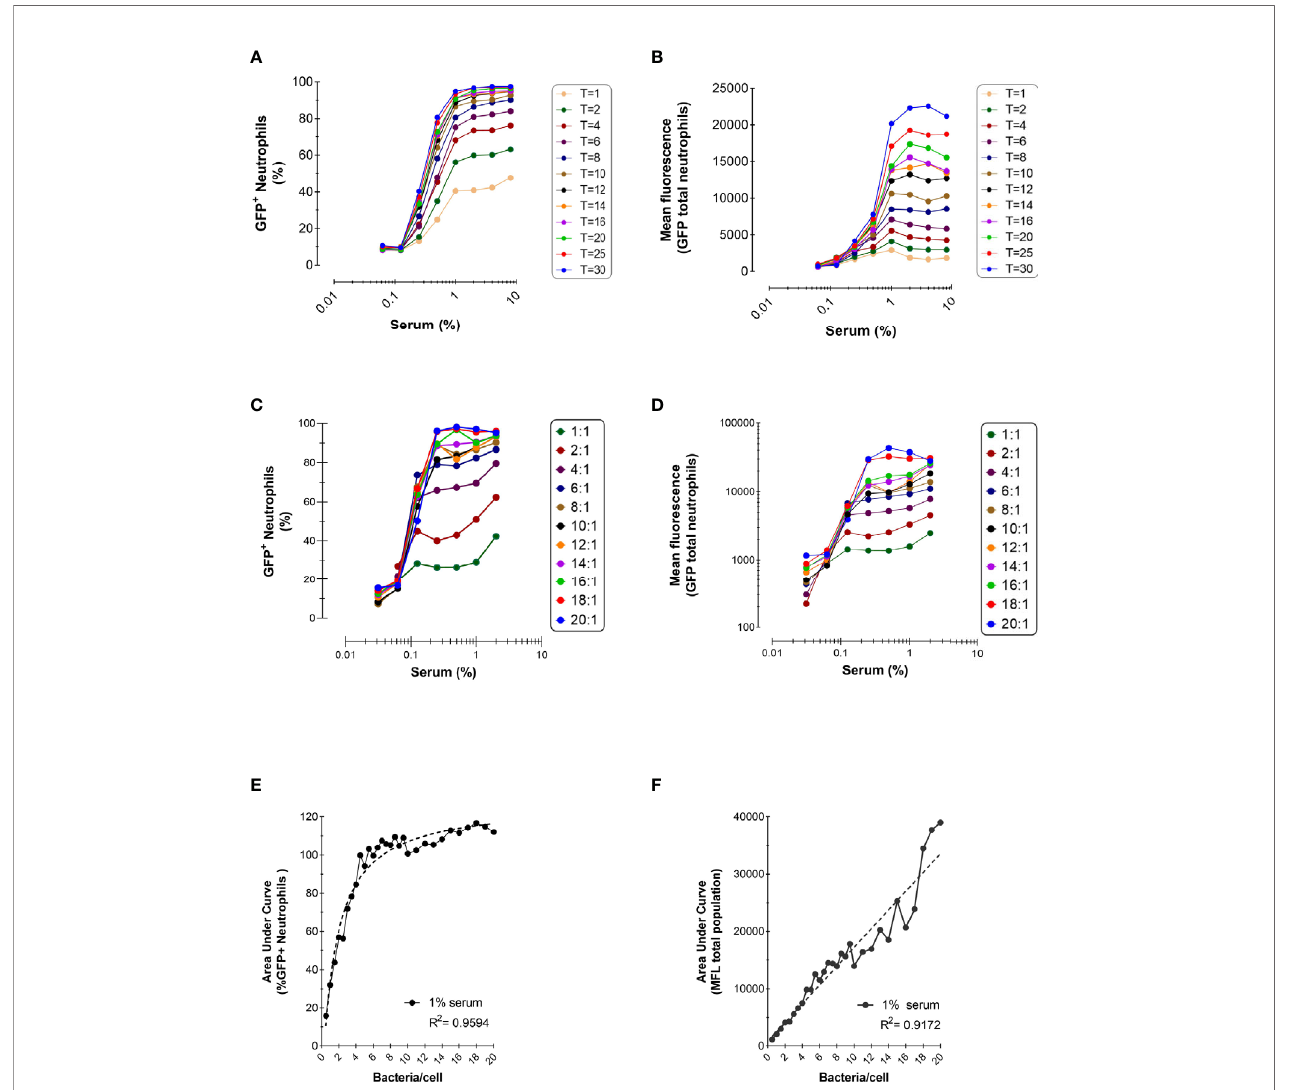
FIGURE 2 | Effect of Incubation Time and Bacteria-to-Cells Ratio on Opsonophagocytosis. (A, B) Time-dependent phagocytosis of KV27-GFP in the presence of pooled NHS. Bacteria and PMNs at a 10:1 ratio were incubated at 37°C in tubes and samples were withdrawn for each time point into ice cold formaldehyde to stop the reaction. Data are expressed as % GFP+ PMNs (A) and Mean fl uorescence (B) . Representative experiment of n=2. (C, D) Phagocytosis of GFP-expressing Newman D SpA D Sbi using different ratios bacteria to neutrophils. Phagocytosis of NHS opsonized bacteria expressed as % GFP+ neutrophils for depicted ratios (C) and as MFL of total neutrophils (D) . (E, F) For 1% serum at different ratios, data of % GFP+ neutrophils are fi tted to a nonlinear regression curve [least squares fi t; GraphPad, Agonist vs. response (three parameters)] (E) and data of total MFL are fi tted to a linear regression curve (F) . Data pooled from n=2